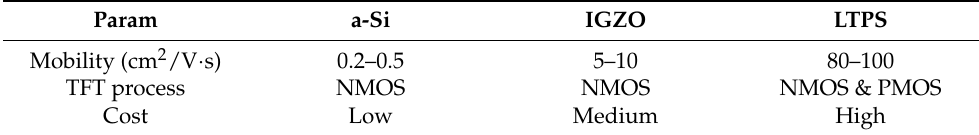
Table 1. A simple comparison of the process of a-Si, IGZO and LTPS TFT.